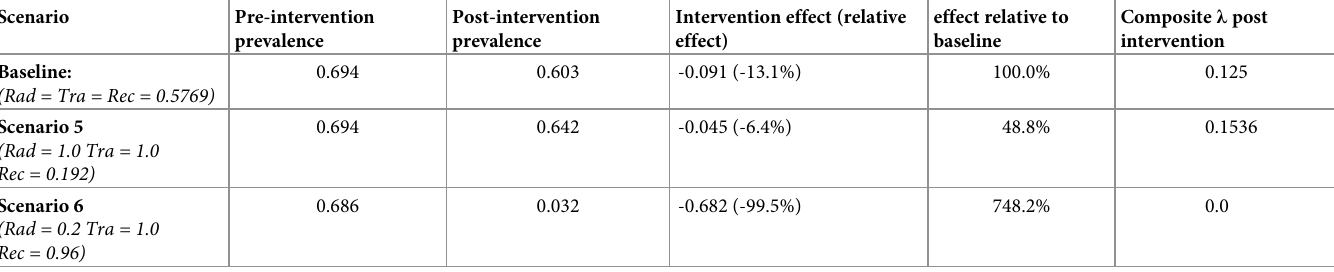
Table 4. Intervention effects for two additional extreme scenarios, under random seeding on network